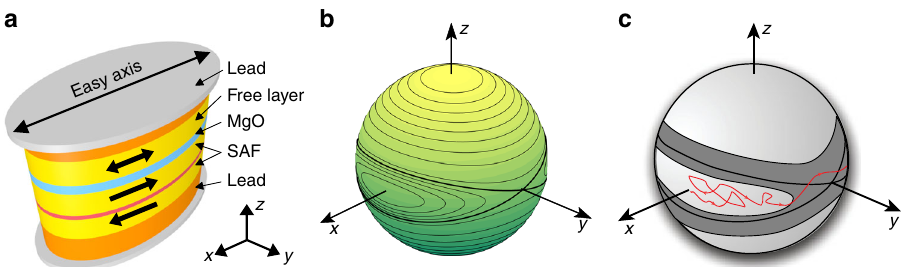
Fig. 1 Device and free layer energy landscape. a Schematics of nanoscale magnetic tunnel junction consisting of a synthetic antiferromagnet (SAF) reference and a superparamagnetic Co 60 Fe 20 B 20 free layer separated by an MgO tunnel barrier. b Unit sphere representing the free layer magnetization direction m with contour lines of constant magnetic anisotropy energy. The biaxial magnetic anisotropy energy landscape consists of two energy minima at m parallel to the x -axis, two energy maxima at m parallel to the z -axis, and two saddle points for m parallel to the y -axis. c Schematic illustration of the effect of ac spin torque on thermally activated switching of the free layer. The free layer nanomagnet switching trajectory m ( t ) must pass through the dark gray band induced by ac spin torque where deterministic magnetization trajectories connect the two potential wells. The presence of this band of chaotic dynamics results in erosion of the boundary between the two potential wells and reduction of the effective energy barrier for thermally activated switching of magnetization between